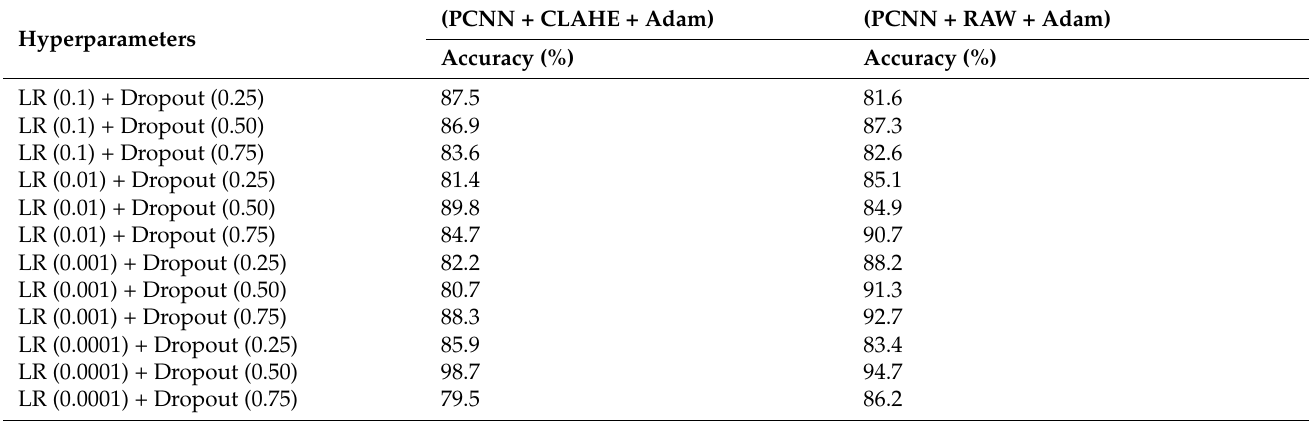
Table 7. Performance evaluation of the proposed PCNN based on different hyper-parameter tuning on our dataset with Adam